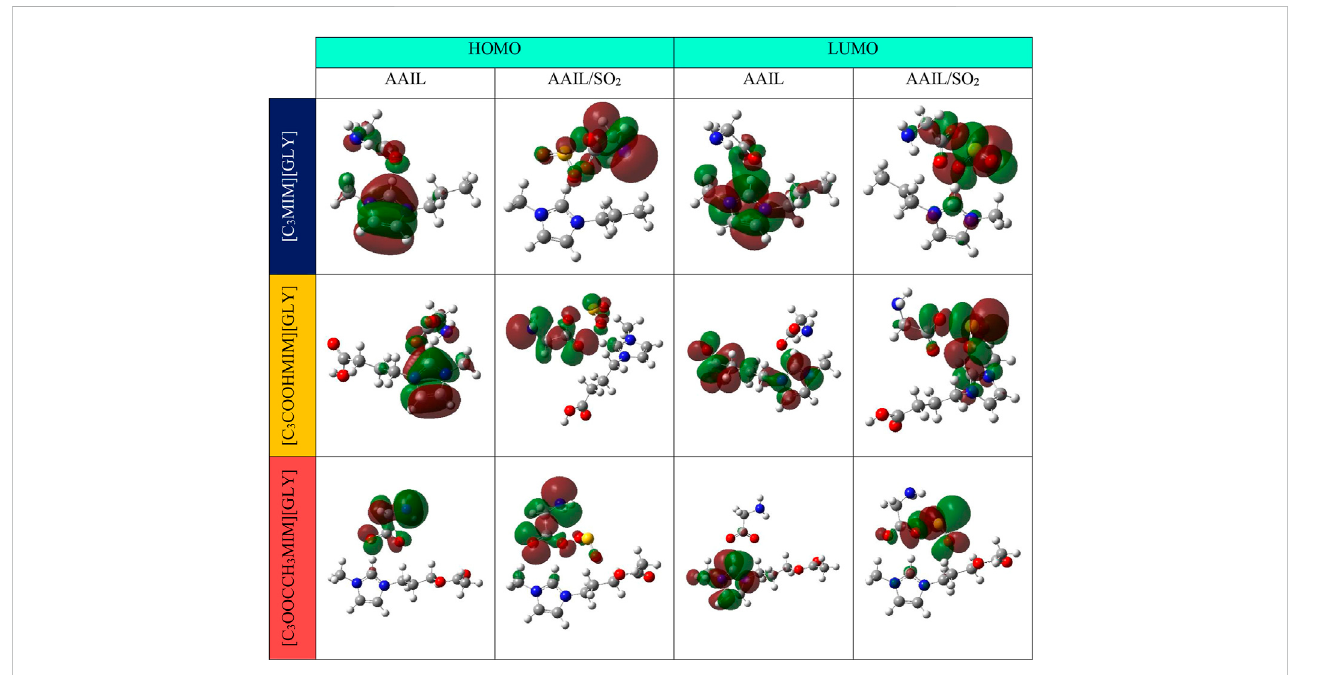
Frontier molecular orbitals for pure AAILs and AAIL ... SO 2